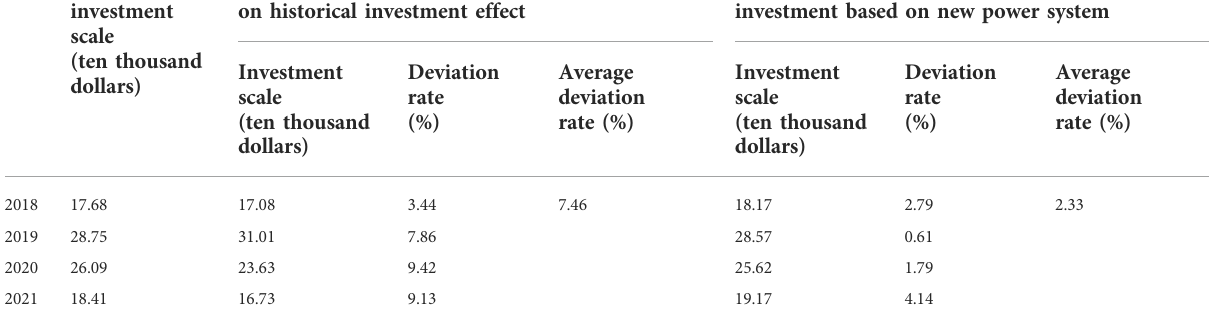
TABLE 2 Comparison of calculation results of two grid investment calculation